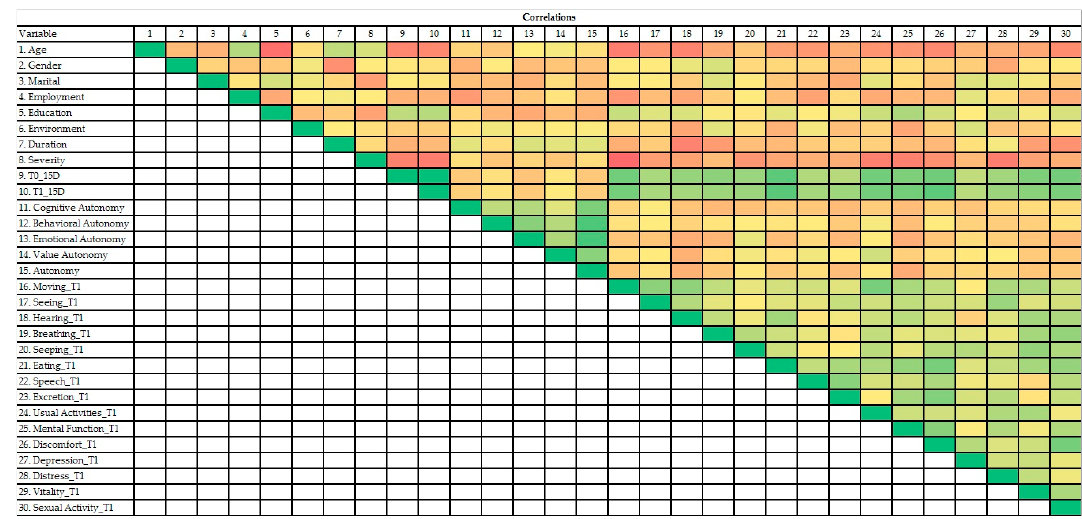
Figure 3. Heatmap of variables’ correlations found in this study.